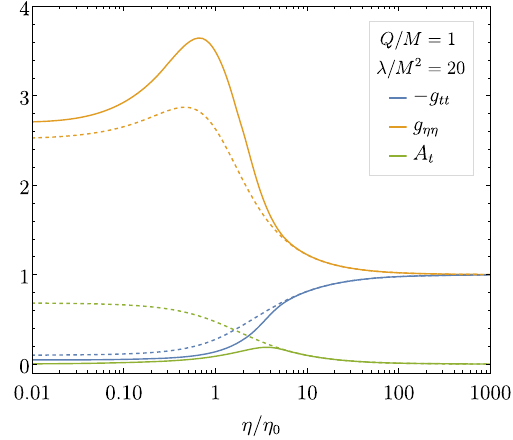
Fig. 4 Same as Fig. 1 for Q / M = 2 and λ/ M 2 =